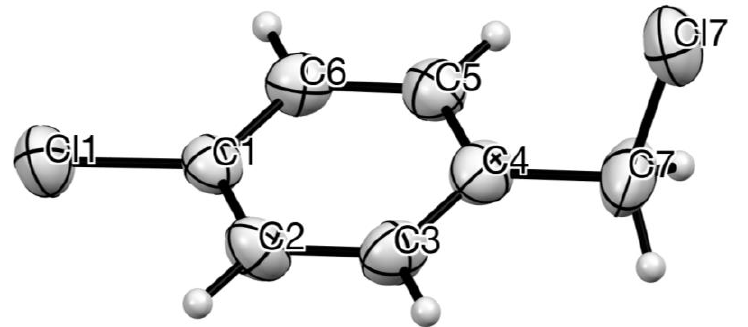
Figure 1. Molecular structure of 1 with anisotropic displacement ellipsoids drawn at 50% probability level and showing numbering system used. Bond lengths and angles: C(1)–Cl(1) 1.724 (7), C(1)–C(2)